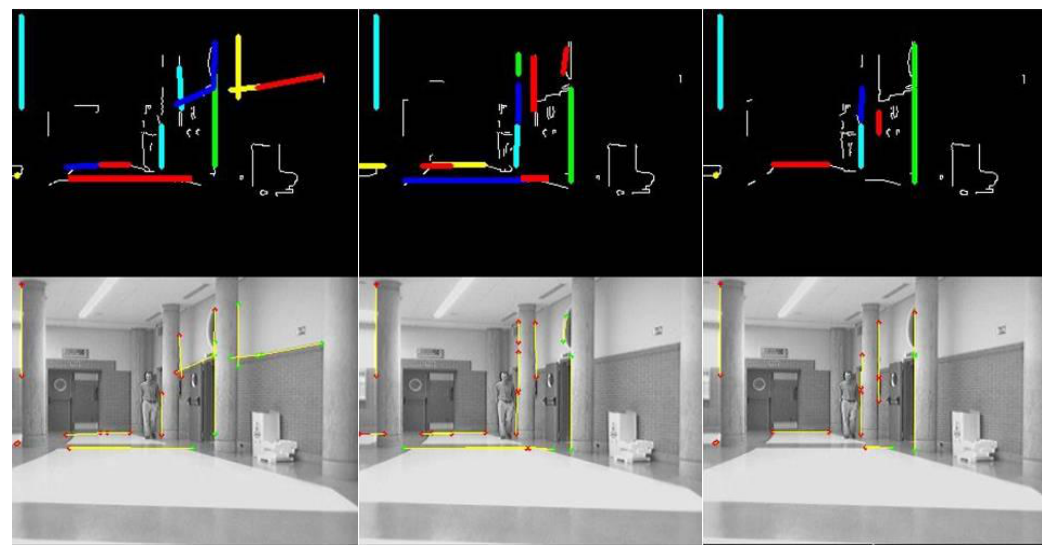
Figure 5. Results of the detection, classification and 3D location process in three frames of a real experiment. Detected structural features and related original